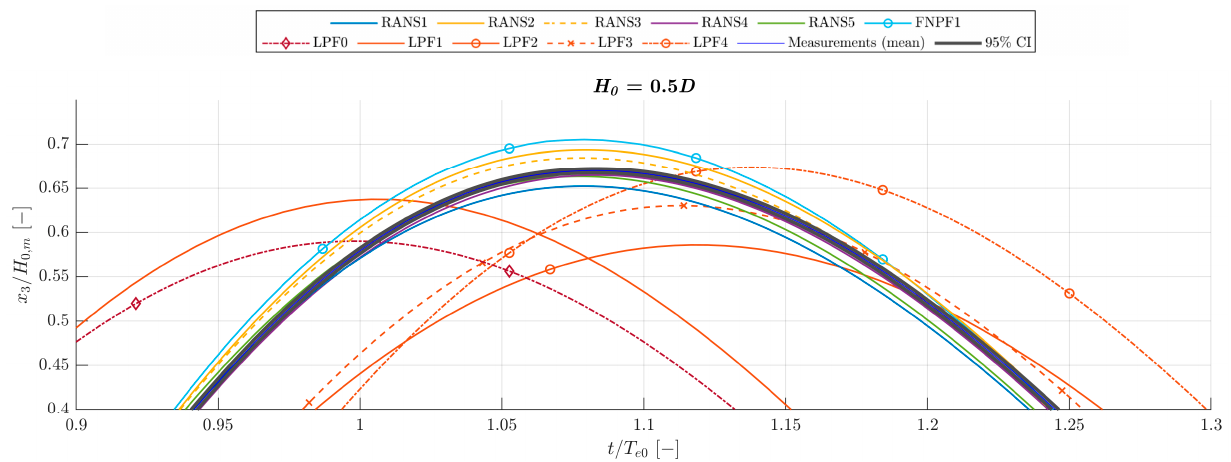
Figure 24. Comparison of physical and numerical test results at the first crest.